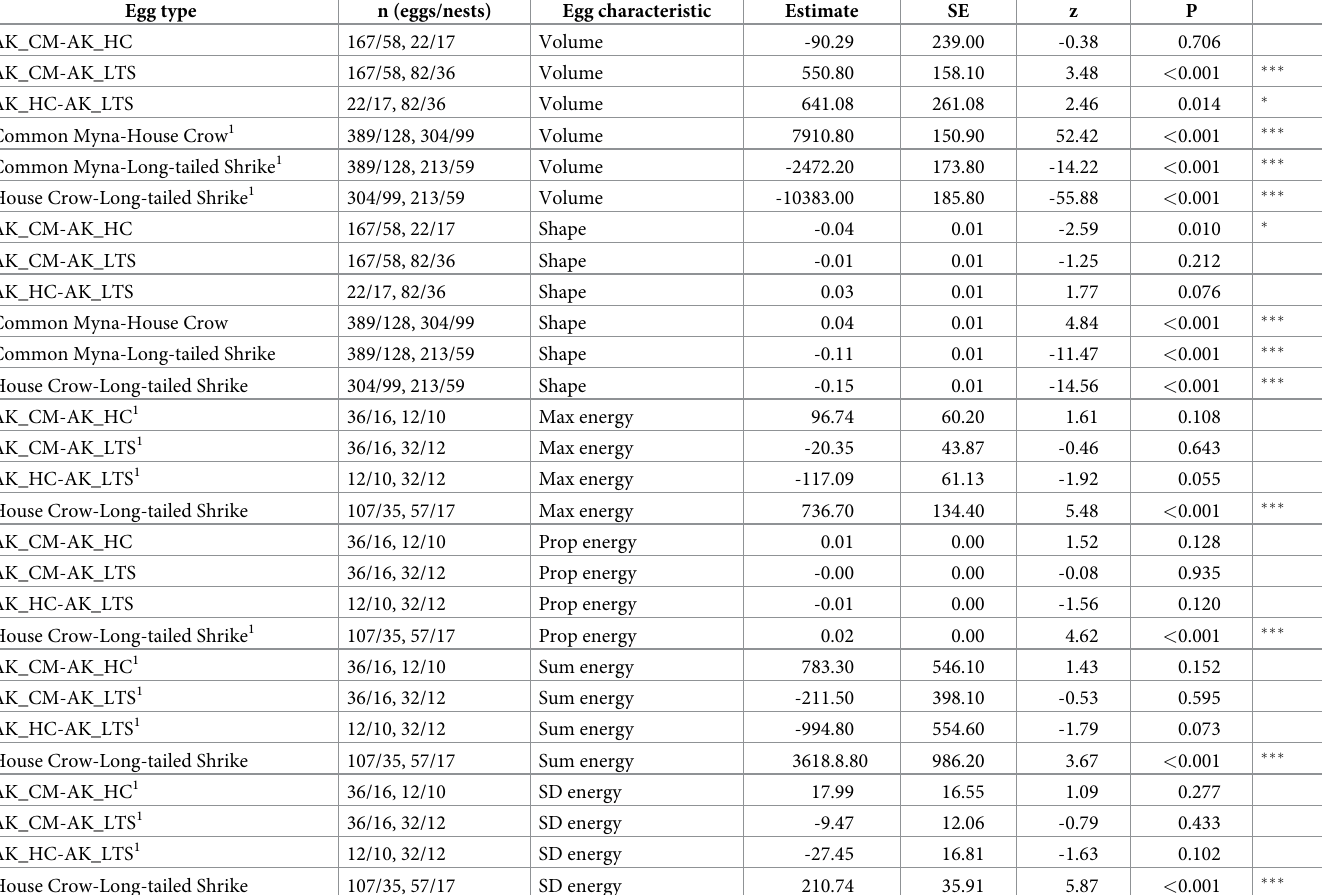
Table 1. Linear mixed-effects models on egg characteristics (volume, shape and spotting pattern) of Asian koel eggs and three host species (common myna, house crow and long-tailed shrike). Egg